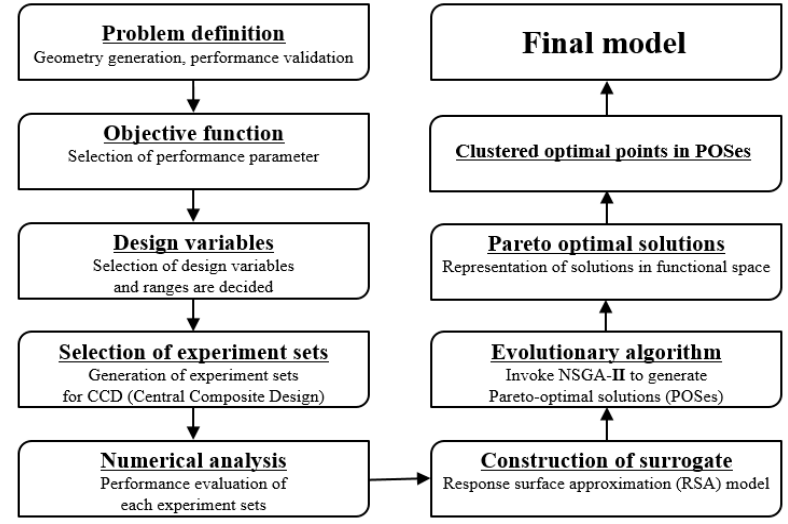
Figure 3. Overall multi-objective optimization procedure.